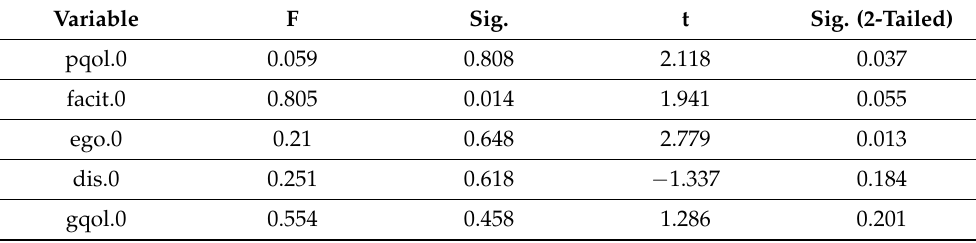
Table 4. Independent sample t -test results of the